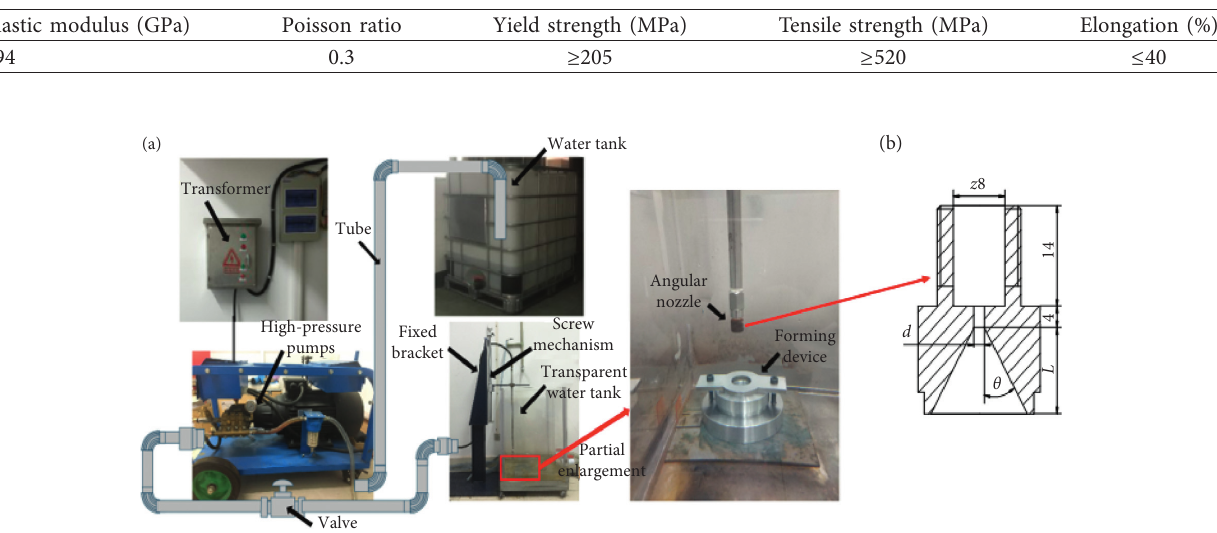
Table 2: Mechanical properties of 304 stainless